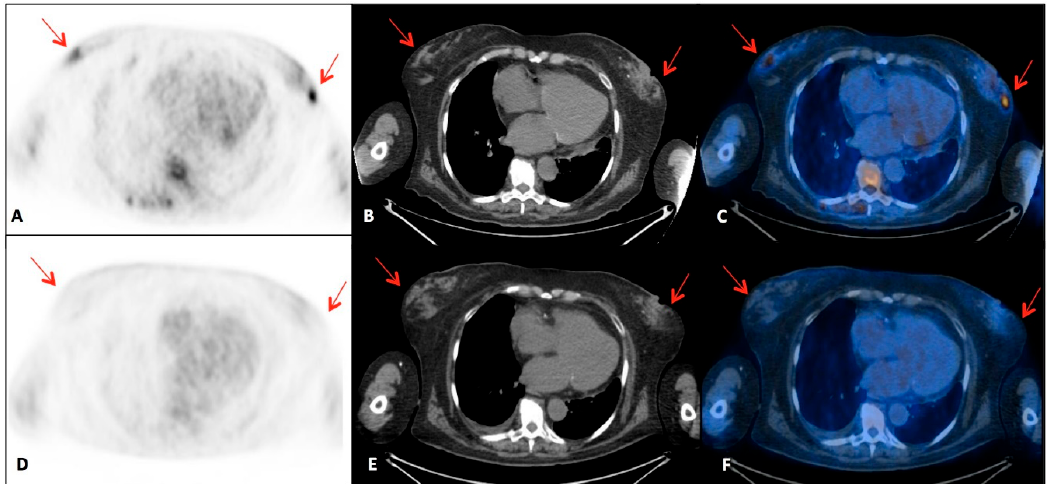
Figure 2. 18 F-FDG-PET / CT examinations performed in a patient a ff ected with breast MS: axial ( A , D ) PET, ( B , E ) CT and ( C , F ) fusion images. ( A – C ) Baseline 18 F-FDG-PET / CT shows bilateral multi-focal breast lesions with increased 18 F-FDG uptake (SUV max 5.4) (red arrows). ( D – F ) Post-radiotherapy 18 F-FDG-PET / CT demonstrates disappeared of the metabolically active lesions previously described (red arrows) and complete response to therapy.